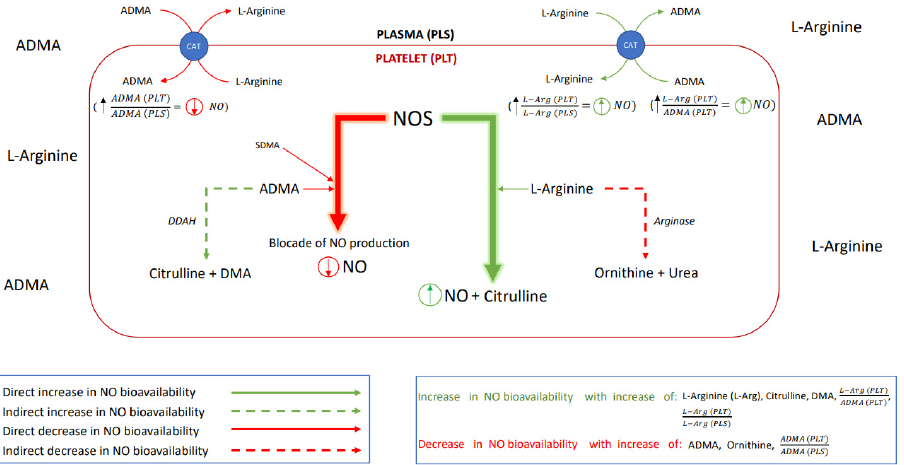
Figure 1. A schematic presentation of the nitric oxide biotransformation. Abbreviations: nitric oxide synthase (NOS), nitric oxide (NO), asymmetric dimethylarginine (ADMA), symmetric dimethylarg- inine (SDMA), dimethylarginine dimethylaminohydrolase (DDAH, an enzyme responsible for ADMA degradation), citrulline, dimethylamine (DMA), L-Arginine (L-Arg), arginase (enzyme re- sponsible for L-Arg degradation), ornithine, urea (product of the L-Arg degradation), cationic- amino acid transporter (CAT, transmembrane L-arginine and ADMA transporter), (cid:3013)(cid:2879)(cid:3002)(cid:3045)(cid:3034) (cid:3036)(cid:3041) (cid:3043)(cid:3039)(cid:3028)(cid:3047)(cid:3032)(cid:3039)(cid:3032)(cid:3047)(cid:3046) ((cid:3017)(cid:3013)(cid:3021)) (comparison of nitric oxide bioavailability in platelet vs. in plasma), (cid:3013)(cid:2879)(cid:3002)(cid:3045)(cid:3034) (cid:3036)(cid:3041) (cid:3043)(cid:3039)(cid:3028)(cid:3046)(cid:3040)(cid:3028)((cid:3017)(cid:3013)(cid:3020)) (cid:3002)(cid:3005)(cid:3014)(cid:3002) ((cid:3017)(cid:3013)(cid:3021)) – (potential for inhibition of NO production in platelet vs . in plasma), (cid:3013)(cid:2879)(cid:3002)(cid:3045)(cid:3034) ((cid:3017)(cid:3013)(cid:3021)) (poten- (cid:3002)(cid:3005)(cid:3014)(cid:3002) ((cid:3017)(cid:3013)(cid:3020)) (cid:3002)(cid:3005)(cid:3014)(cid:3002) ((cid:3017)(cid:3013)(cid:3021)) tial for the platelet NO synthesis). 2. Materials and Methods 2.1. Recruitment of Patients A total of 418 patients with diagnosis of ischemic stroke, admitted to the University Clinical Hospital in Wroclaw were enrolled in this study. A total of 98 of them were dis- qualified due to the prolonged time between first neurological symptoms and admission to the hospital (>24 h). Subsequently, 230 patients have undergone thrombolysis and/or thrombectomy and therefore met exclusion criteria. The next 49 patients presented other exclusion criteria. Only one subject revoked informed consent to participate in the study, while none of the patients died during study observation. Finally, a total number of 40 patients at age of 29–80 years with diagnosed acute ischemic stroke were included in the study group. A flow chart presenting the recruitment of the subjects with stroke to the study is presented in Figure 2.